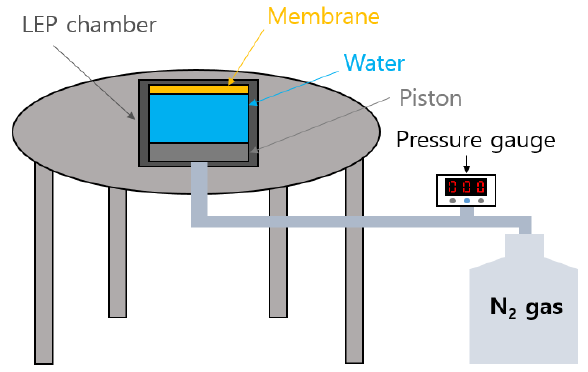
Figure 1. Schematic drawing of LEP apparatus.